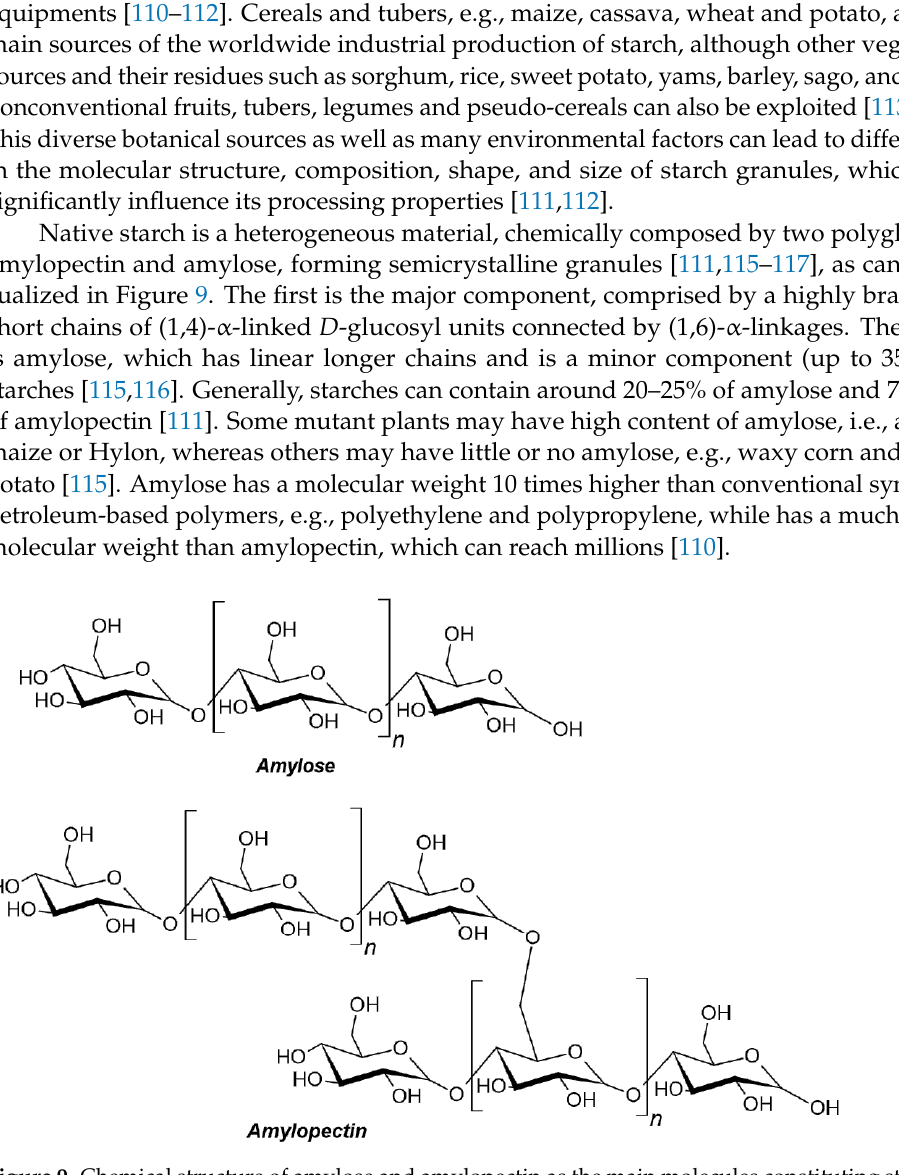
Figure 9. Chemical structure of amylose and amylopectin as the main molecules constituting starches. The amylose/amylopectin ratio is influenced by the starch origin and, consequently, leads to different crystallinity degrees. The technological properties of starches depend on their crystallinity, which can vary from 20% to 45% [110,111,117,118]. Mainly because of the presence of strong intermolecular hydrogen bonds, starches are not solubilized in cold water. In hot water, these bonds are weakened by the interaction between water molecules and hydroxyl groups of amylose and amylopectin, which leads to partial starch solubili- zation [111]. When in solution, amylose can crystallize, forming left-handed double heli- ces, which are packed in, either A- or B-type allomorphs [115]. This phenomenon is called retrogradation. The temperature, solvent and starch/solvent ratio used for solubilizing starch are significant factors that can influence its gelatinization, a relevant process in the production of starch-based films and coatings [111]. Different physicochemical reactions occur during the thermal processing of starches, such as water diffusion, granule swelling, gelatinization, decomposition, melting and crystallization, though the gelatinization is among the most important [110]. Physicochemical techniques, e.g., X-ray diffraction, po- larized microscopy, nuclear magnetic resonance, and differential scanning calorimetry are commonly used to investigate the gelatinization process of starch [110]. Starch-based films can be prepared by using a wet or dry process. In the first, the films are made by film-forming dispersion using the casting technique. In the second, by thermoplastic or thermal processing using extruders, thermoplastic starch is produced [110,111,117]. Starches form suspensions with good film-forming capability. Similar to other natural polymer films, the starch-based films exhibit several advantages. Starch films are tasteless, colorless and odorless. They present good oxygen barrier properties, nutritional value, edibility and others [105,118]. However, due to their hydrophilic nature, starch films have some disadvantages, mainly related to their low water vapor barrier capacity and mechanical properties [114,117]. To overcome these limitations, some plasticizers and other hydrophobic substances (e.g., polyols, as well as the incorporation of other natural polysaccharides and proteins to form composite films) can be added to improve the water vapor barrier and mechanical properties [77,111,117,119]. Glycerol is among the most used and best plasticizer for